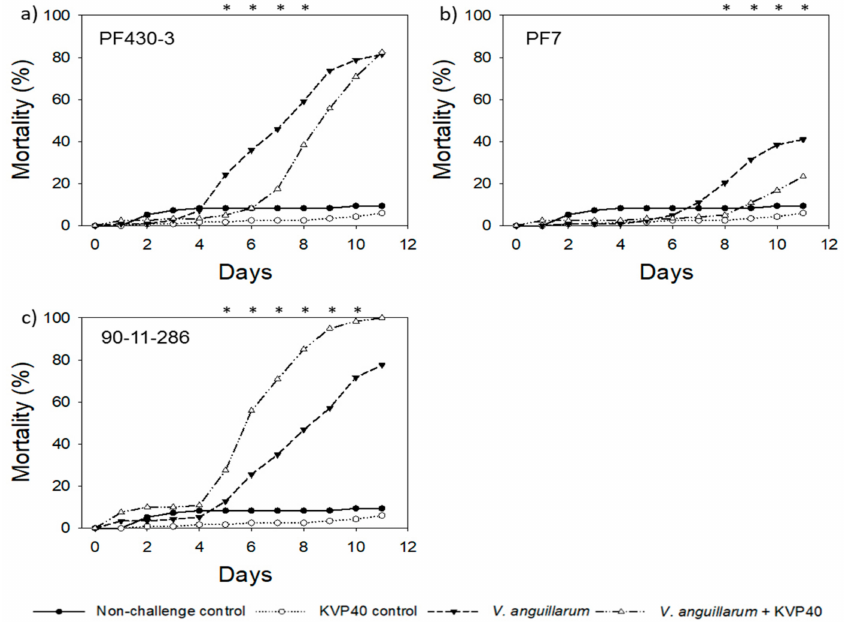
Figure 4. Cumulative percent mortality over time in cod challenge trial 1: ( a ) strain PF430-3; ( b ) strain PF7; ( c ) strain 90-11-286. Significant difference in mortality between cultures “ V. anguillarum ” and “ V. anguillarum + KVP40” for individual time points is indicated by